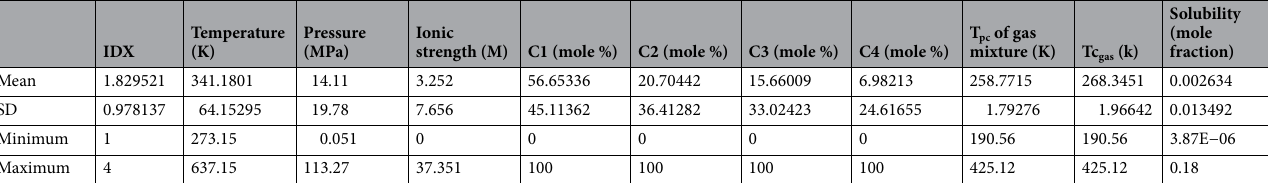
Table 2. Statistical description of the solubility databank utilized in the present